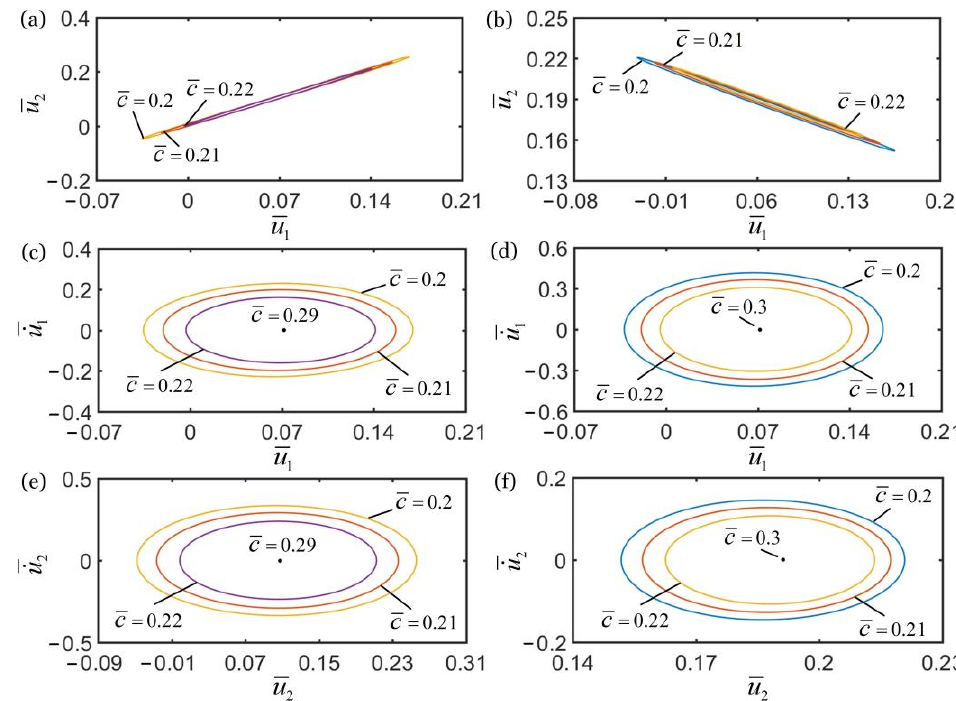
Figure 8. The effect of damping coefficient c on self-oscillations of the two coupled oscillators. ( a ) Domain of attraction, and ( c , e ) limit cycles for in-phase regime of k 2 = 16. ( b ) Domain of attraction, and ( d , f ) limit cycles for anti-phase regime of k 2 = 4.5. In the computation, the other geometric and material parameters are given in Table 2. With the increase of c , the amplitudes of self-oscillations of two coupled oscillators